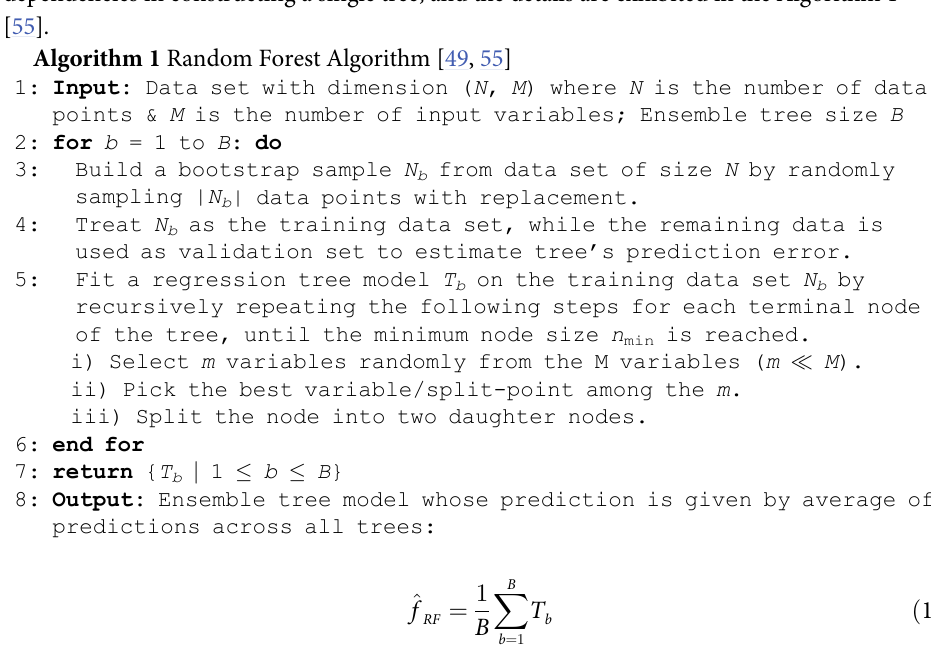
Algorithm 1 Random Forest Algorithm [49,